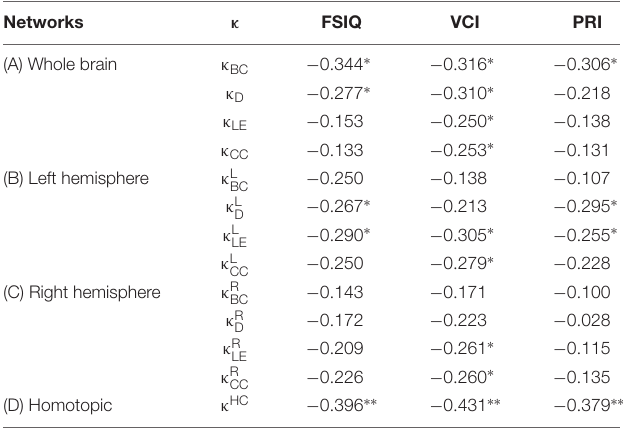
TABLE 3 | Coefficients of non-parametric correlations ( ρ ) between the hub disruption index ( κ ) of different nodal metrics [betweenness centrality (BC), degree (D), local efficiency (LE), clustering coefficient (CC), and homotopic connectivity (HC)] with intelligence scores [FSIQ, VCI, and PRI] at different network levels: whole brain (A), left and right hemispheres (B and C), and homotopic regions (D).